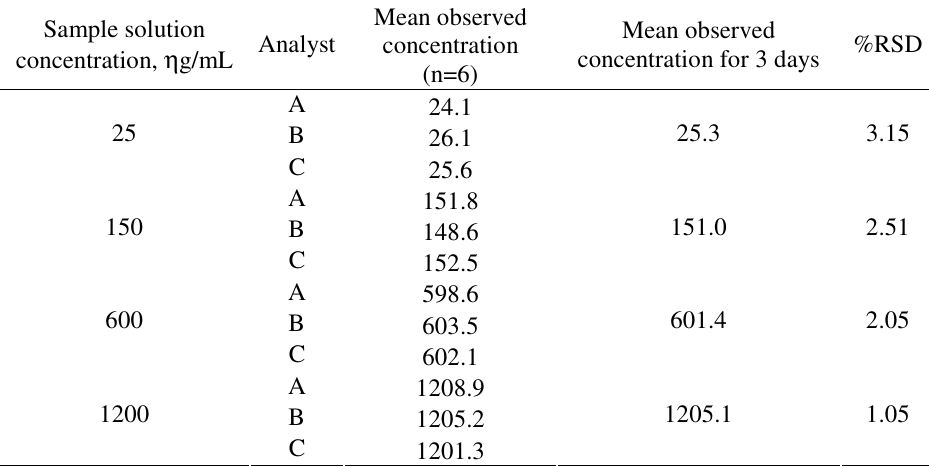
Table 4. Between-analysts precision data for the determination of voglibose in samples using